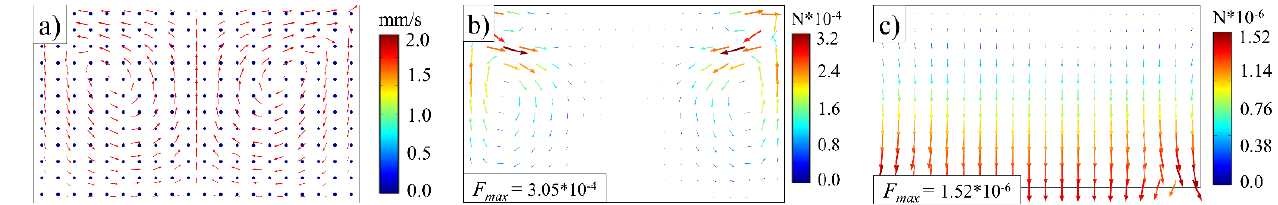
Figure 3. Melt stream velocity distribution in ( a ) the plasticizing chamber, ( b ) radial and ( c ) axial directions along the dash lines (ultrasonic frequency, 20 kHz; ultrasonic amplitude, 80 μm ; melt height, 6 mm; fluorescent particles distribution, uniform).